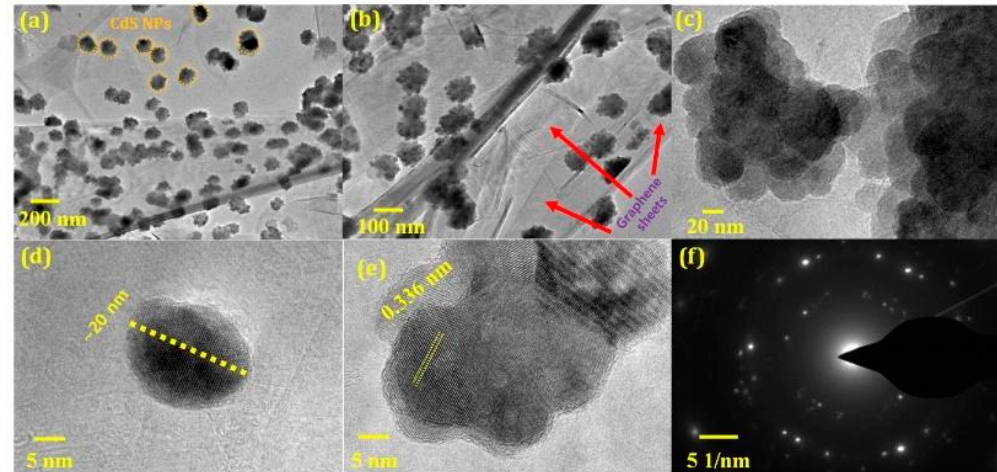
Figure 6. TEM images of (a, b) graphene sheets decorated with CdS NPs in Gr–CdS nanocomposite, (c) CdS NPs on the sheet, (d) crystal size, (e) lattice fringes, and (f) SAED pattern.